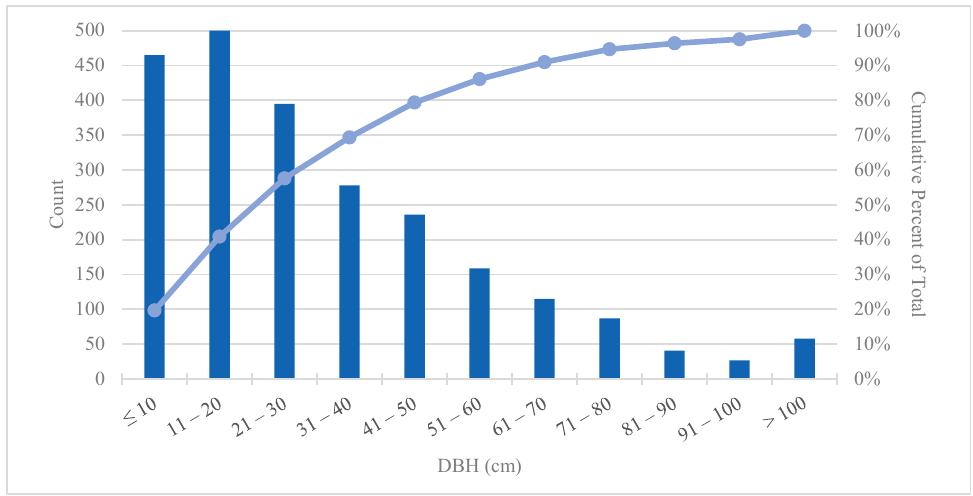
Figure 3. Distribution of trunk diameter 1.4 m above ground (DBH) of all trees ( n = 2361).